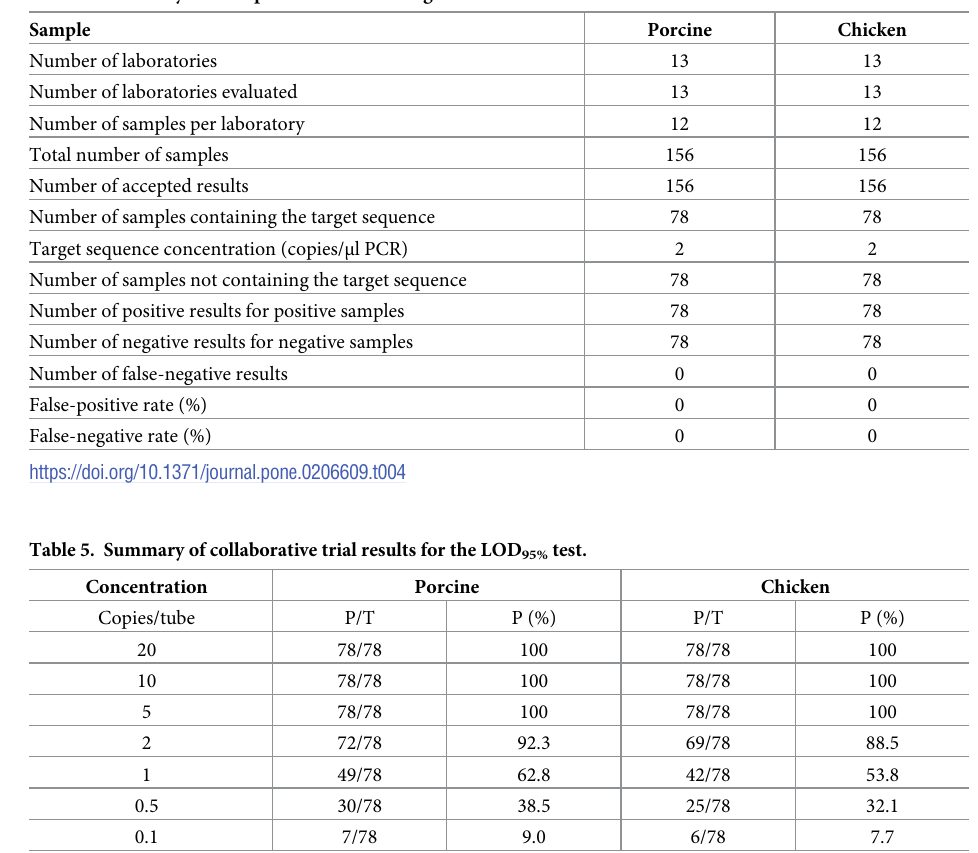
P, number of positive results; T, total number of tests; P (%), positive rate.